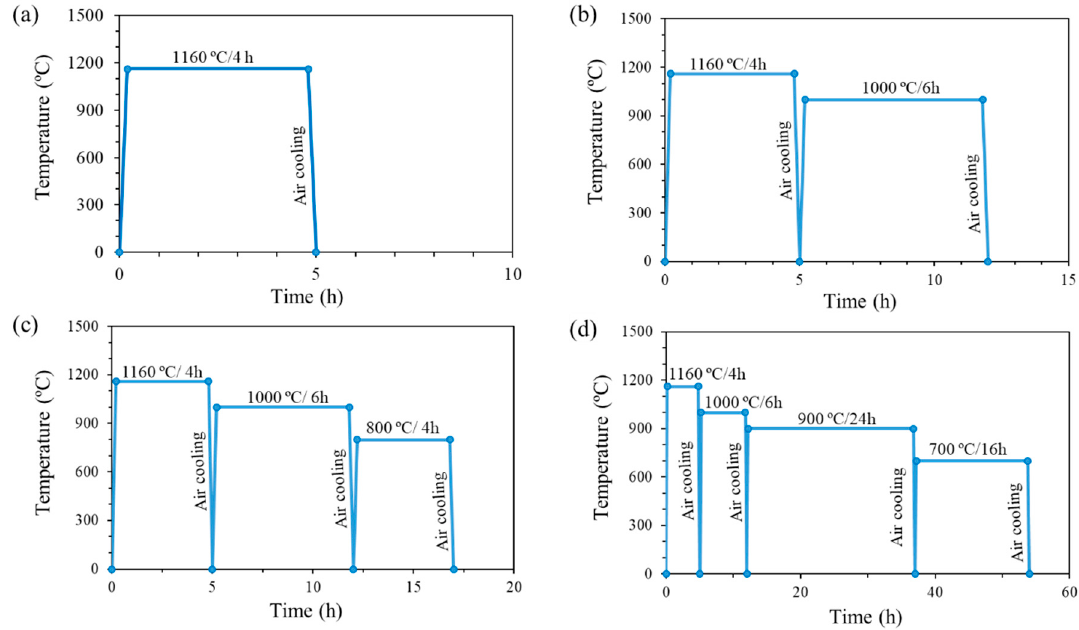
Figure 2. Applied heat treatment process; ( a ) process A, ( b ) process B, ( c ) process C and ( d ) process D.